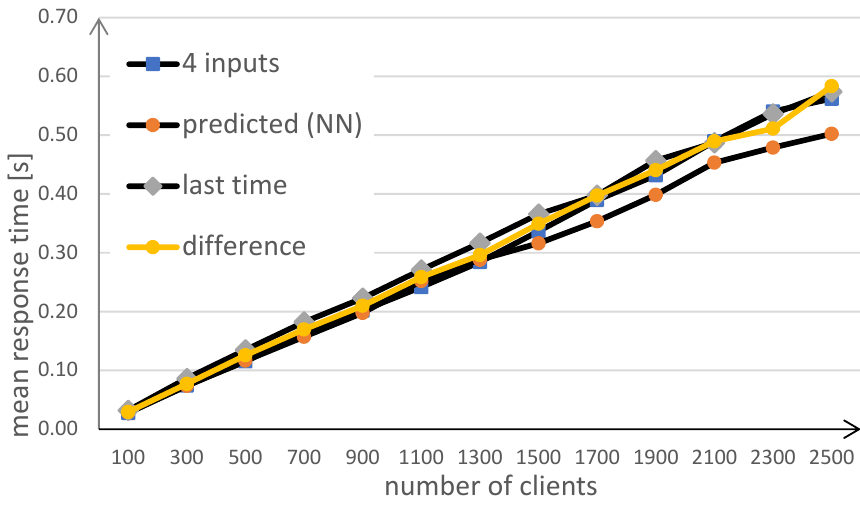
Figure 11. Comparison of the results for modified neural networks.